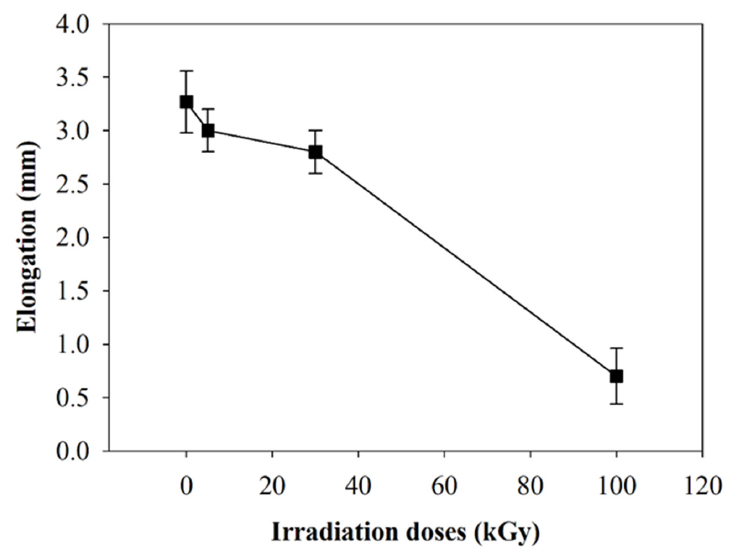
Figure 9. The e ff ect of electron-beam irradiation to the elongation of PLLA / CMS / β -TCP Figure 9. The effect of electron-beam irradiation to the elongation of PLLA/CMS/ β -TCP nanofibers.